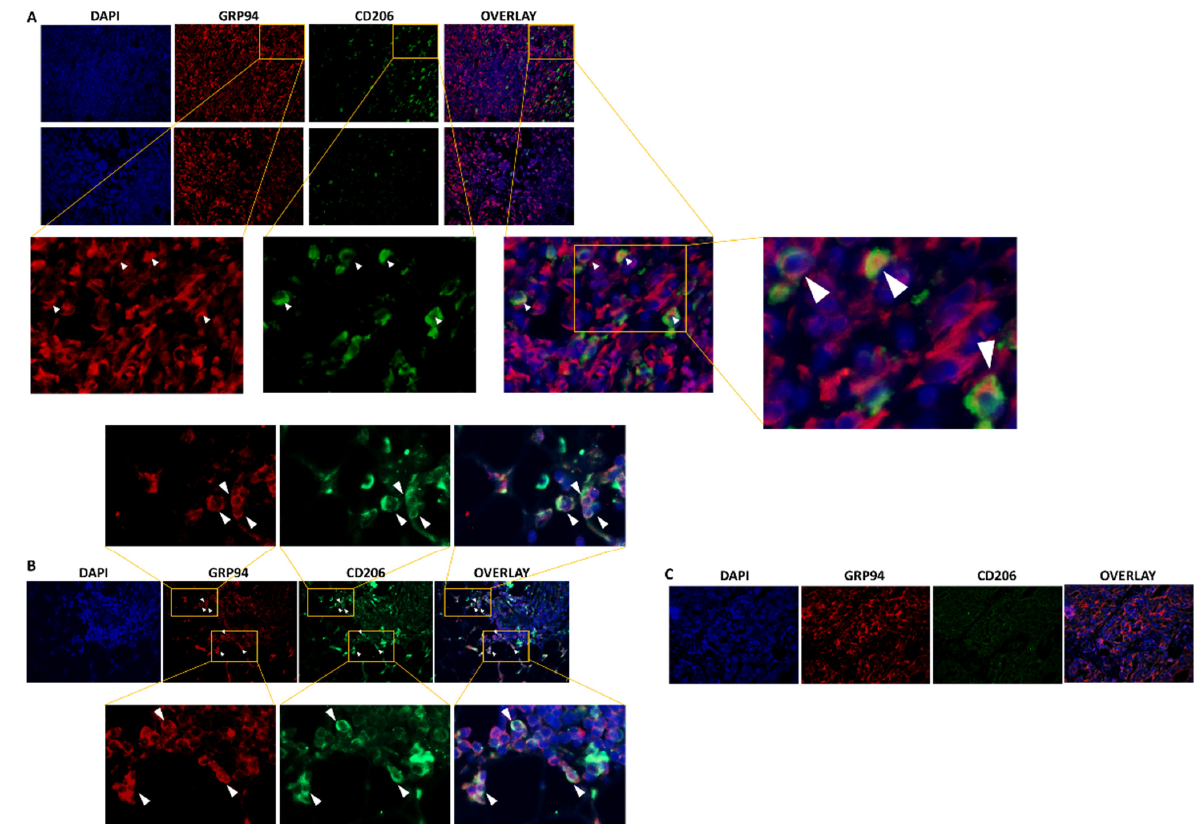
Figure 1. GRP94 and CD206 are co-expressed in murine and some human TNBC tumors. ( A ). Representative immunostaining of GRP94 (red) and CD206 (green) in 4T1 tumor-bearing mice ( n = 8). ( B ). Representative immunostaining of GRP94 (red) and CD206 (green) in a biopsy from a human TNBC tumor infiltrated with CD206 + M2-like macrophages ( n = 3). ( C ). Representative immunostaining of GRP94 (red) and CD206 (green) in a biopsy from a human TNBC tumor non infiltrated with CD206 + M2-like macrophages ( n = 3).